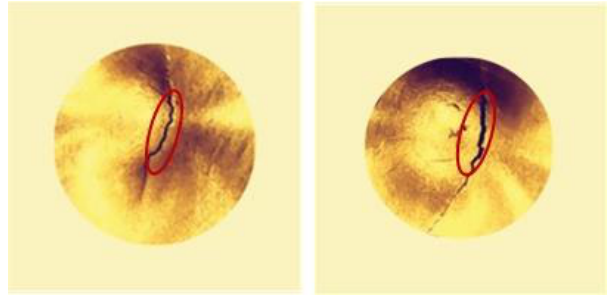
Figure 14. Micro-cracks on the samples when the crack appears at the bottom of the samples.